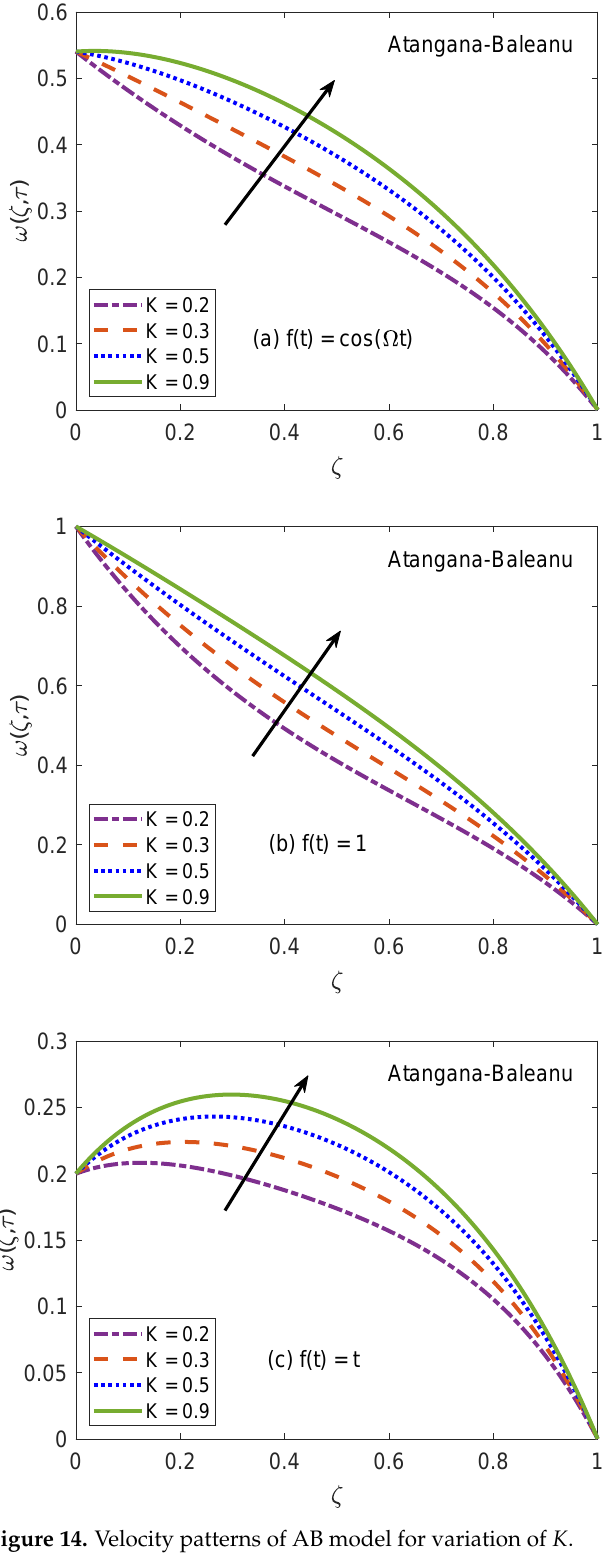
Figure 14. Velocity patterns of AB model for variation of K